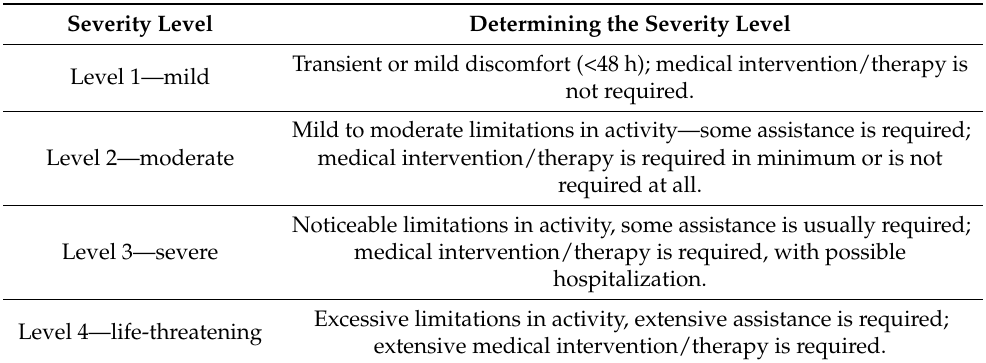
Table 5. Adverse drug reaction severity levels among children with tuberculosis in Uzbekistan,